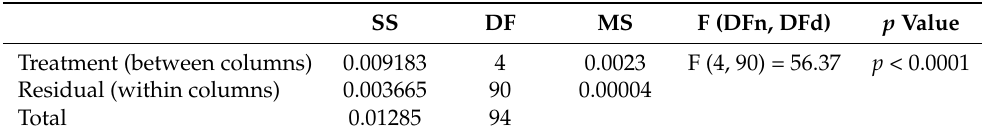
Table 13. The results of the analysis of variance (ANOVA) test for evaluating the proposed SCBER+NN approach.